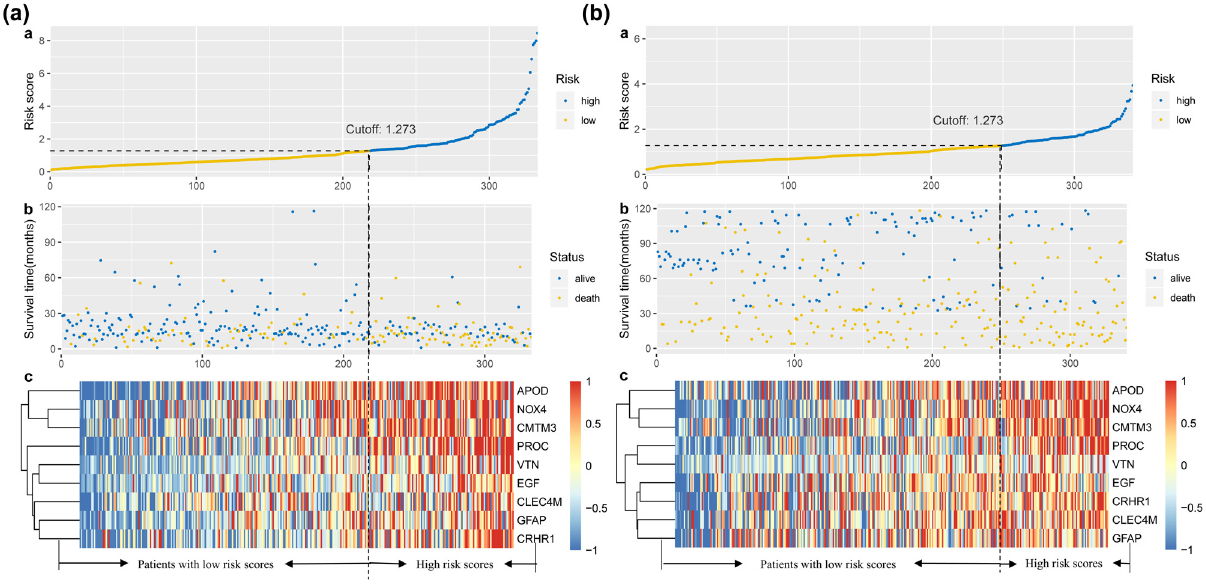
Figure 1: The prognostic signature in gastric cancer. ( a ) TCGA cohort: ( a ) risk score of each colon cancer: the risk score increased from yellow to blue; ( b ) survival time of each colon cancer: blue and yellow scatter represent alive and dead, respectively; ( c ) heatmap of the signature of nine immune - relevant genes. ( b ) GSE84437 cohort: ( a ) risk score of each gastric cancer: the risk score increased from yellow to blue; ( b ) survival time of each colon cancer: blue and yellow scatter represent alive and dead, respectively; ( c ) heatmap of the signature of nine immune - relevant genes.